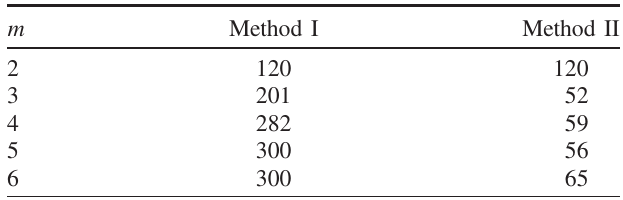
TABLE I. Cases (out of 300) where the nonlocality of the chain state in Fig. 9 (left) is detected via the connector contraction in Fig. 9 (right) for two different methods to choose the connectors. The numbers in the first row are the same because both methods are equivalent for m ¼ 2 .